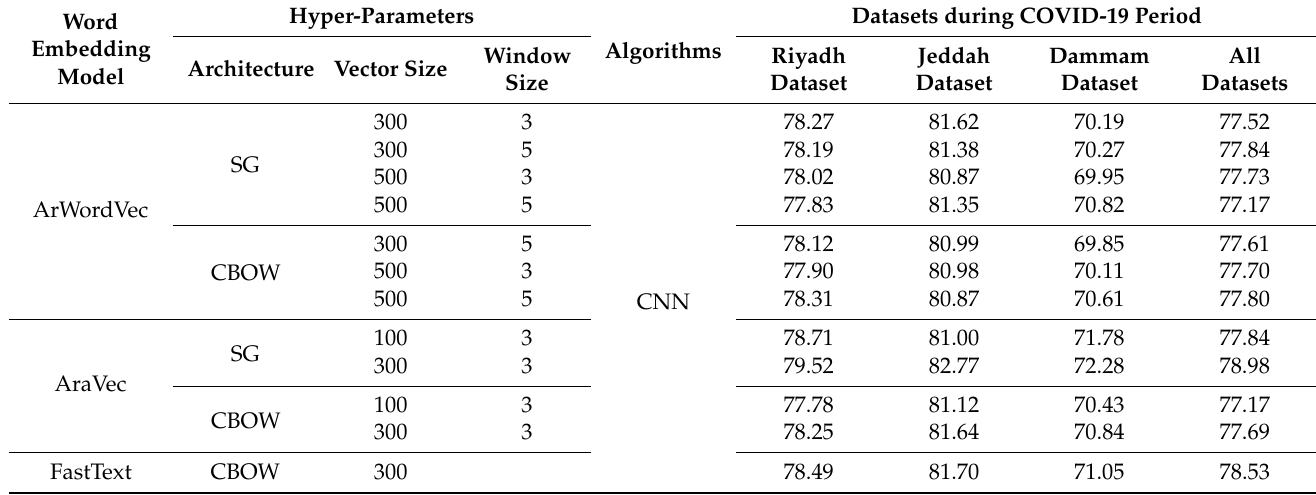
Table 8. The Accuracy metric of CNN and BiLSTM algorithms when using different Arabic pre- trained word embedding techniques for the dataset during